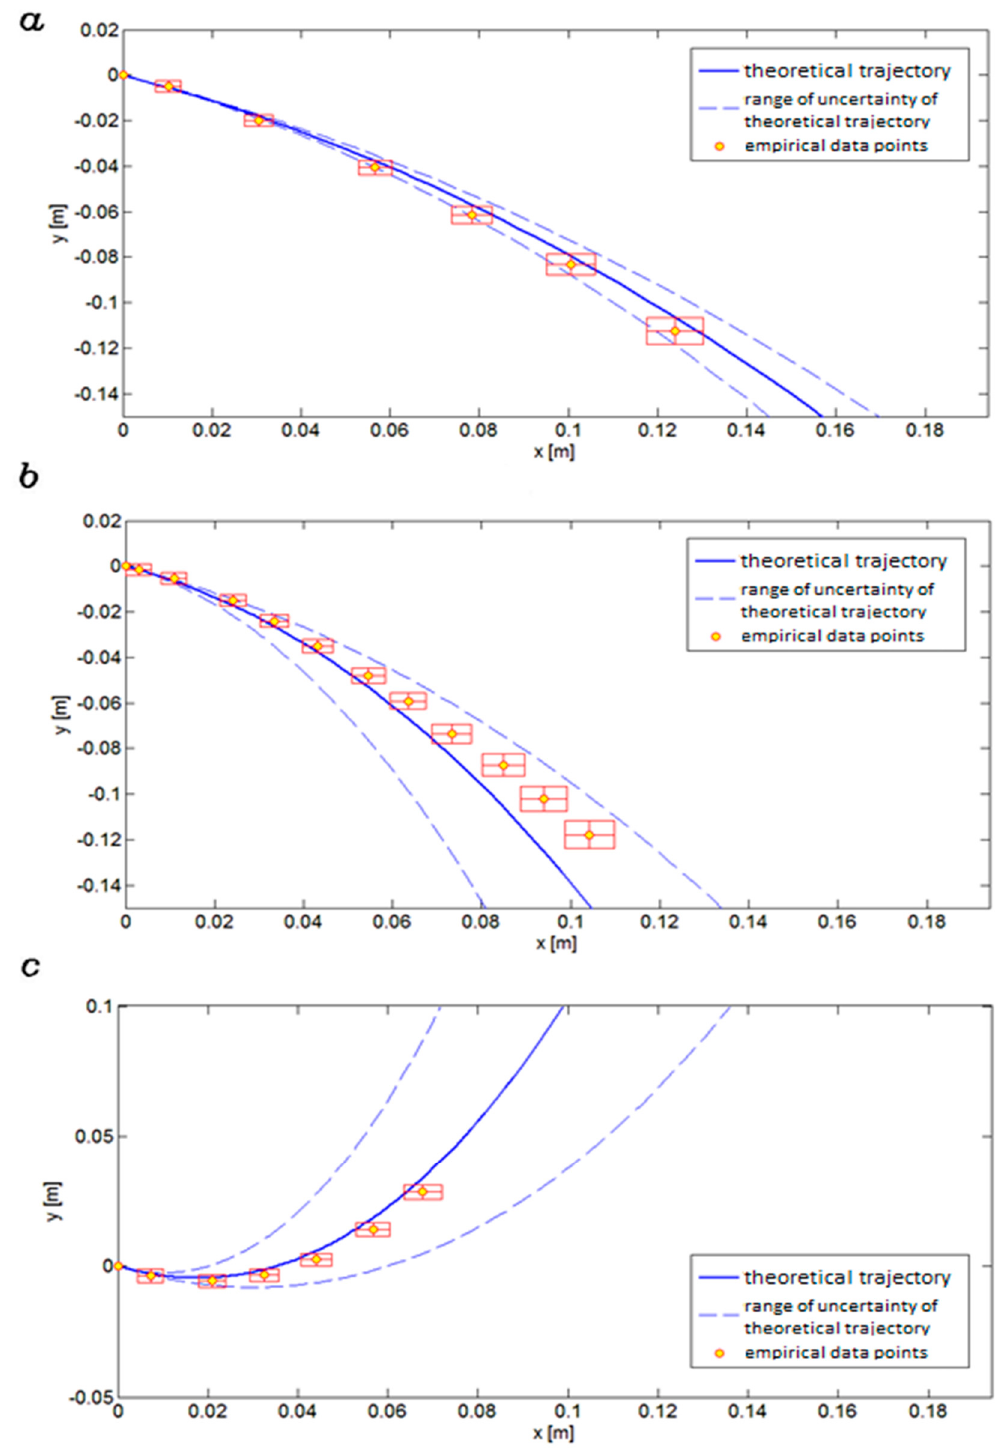
Figure 10. Theoretical and empirical trajectory of the particle ( α = − 27°) at ( a ) v f = 2.7 m/s, v 0 = 1.4 m/s; ( b ) v f = 6.2 m/s, v 0 = 0.6 m/s; and ( c ) v f = 12.8 m/s, v 0 = 0.8 m/s. v 0 = 0.6 m/s; and ( c ) v f = 12.8 m/s, v 0 = 0.8